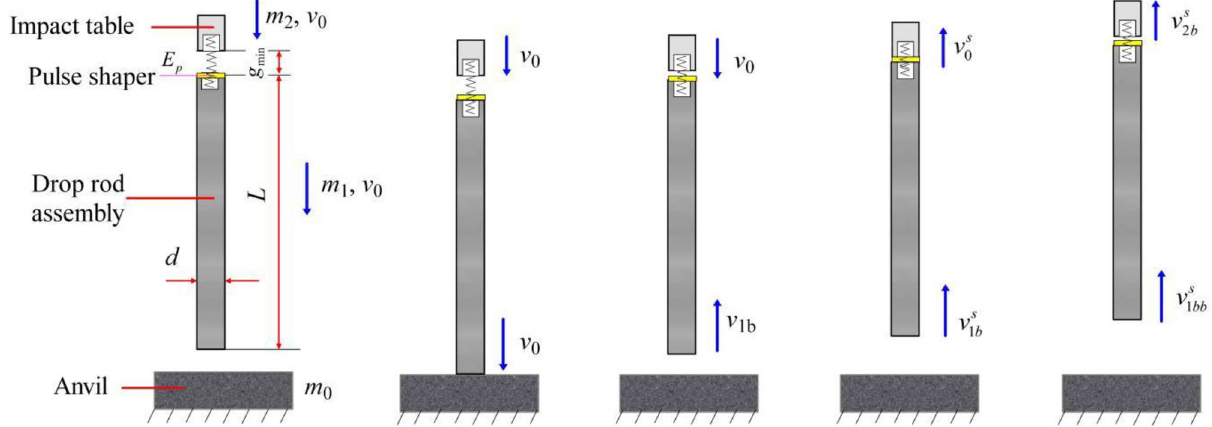
Figure 3. Model for a one-dimensional three-body collision that includes a suspension spring. In the figure, E p represents the initial elastic potential energy of the suspension spring before the collision, g min is the required s v s minimum suspension gap, v 0 and 1 b are the velocities of m 1 and m 2 before the collision, respectively, and v